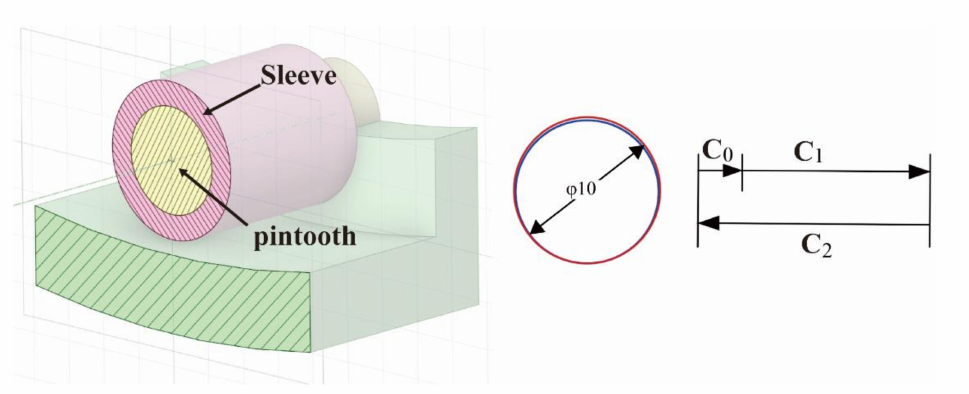
Figure 10. Assembly dimension chain of the improved